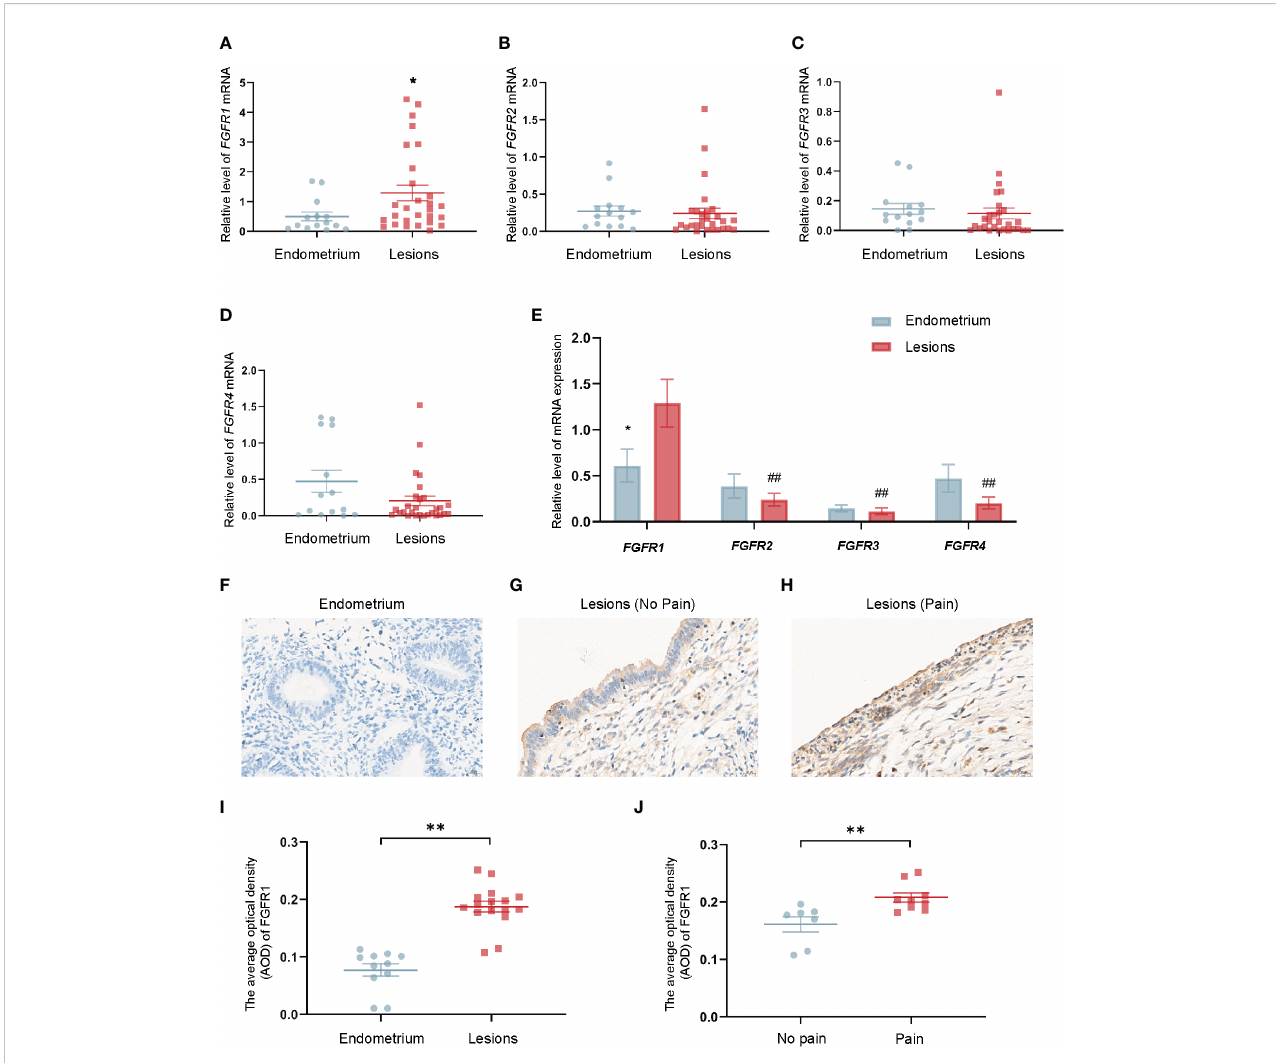
FIGURE 5 Upregulated FGFR1 in ovarian endometriotic lesions is correlated with patients ’ pain severity. (A) The mRNA level of FGFR1 in control endometrium (n = 14) and ovarian endometriotic lesions (n = 28). (B) The mRNA level of FGFR2 in control endometrium (n = 14) and ovarian endometriotic lesions (n = 28). (C) The mRNA level of FGFR3 in control endometrium (n = 14) and ovarian endometriotic lesions (n = 28). (D) The mRNA level of FGFR4 in control endometrium (n = 14) and ovarian endometriotic lesions (n = 28). (E) The mRNA level of FGFR1,2,3,4 in control endometrium (n = 14) and ovarian endometriotic lesions (n = 28). (F) Representative IHC images of FGFR1 in tissues from control endometrium, 400×, bar = 20 m m. (G) Representative IHC images of FGFR1 in ovarian endometriotic lesions from patients without pain, 400×, bar = 20 m m. (H) The representative IHC images of FGFR1 in ovarian endometriotic lesions from patients with pain symptoms, 400×, bar = 20 m m. (I) Average optical density of FGFR1 in control endometrium (n = 11) and ovarian endometriotic lesions (n = 16). J Average optical density of FGFR1 in ovarian endometriotic lesions from patients without (n = 7) and with (n = 9) pain symptoms. * P < 0.05, ** P < 0.01 (control endometrium vs. ovarian endometriosis lesions; no pain vs. pain); ## P < 0.01 ( FGFR2 , FGFR3 , FGFR4 vs. FGFR1